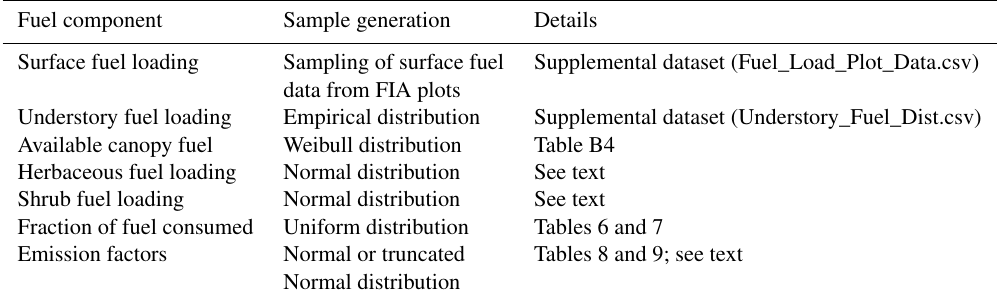
Table 10. Sample generation methods employed in Monte Carlo style simulation of emission intensity